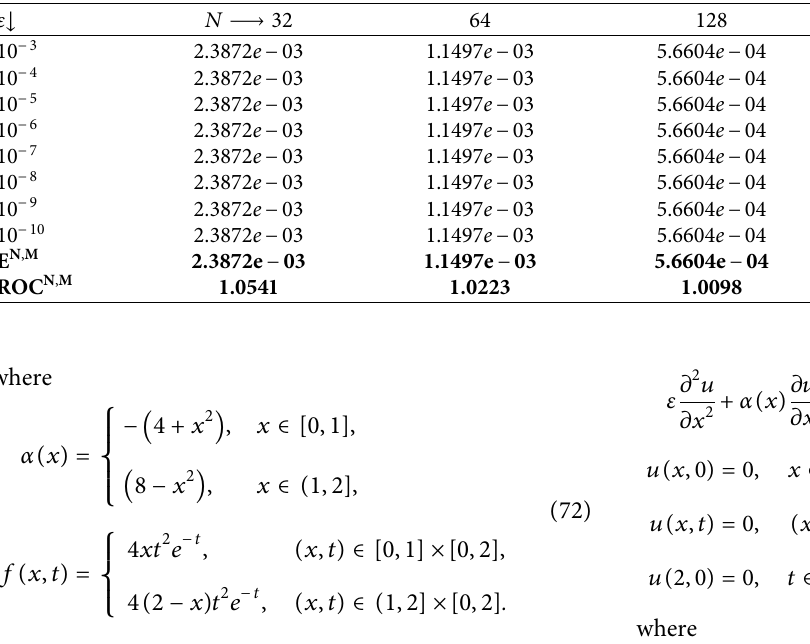
Figure 4: One dimensional plot and log-log plot for Example 2 (a) Numerical solution at t � 2, when N � 32, (b) Log-log Table 1: Computed maximum point-wise errors, ε -uniform errors ( E N,M ) , and the ε − uniform rate of convergence ROC N,M for Example 1 when M � N , before extrapolation.